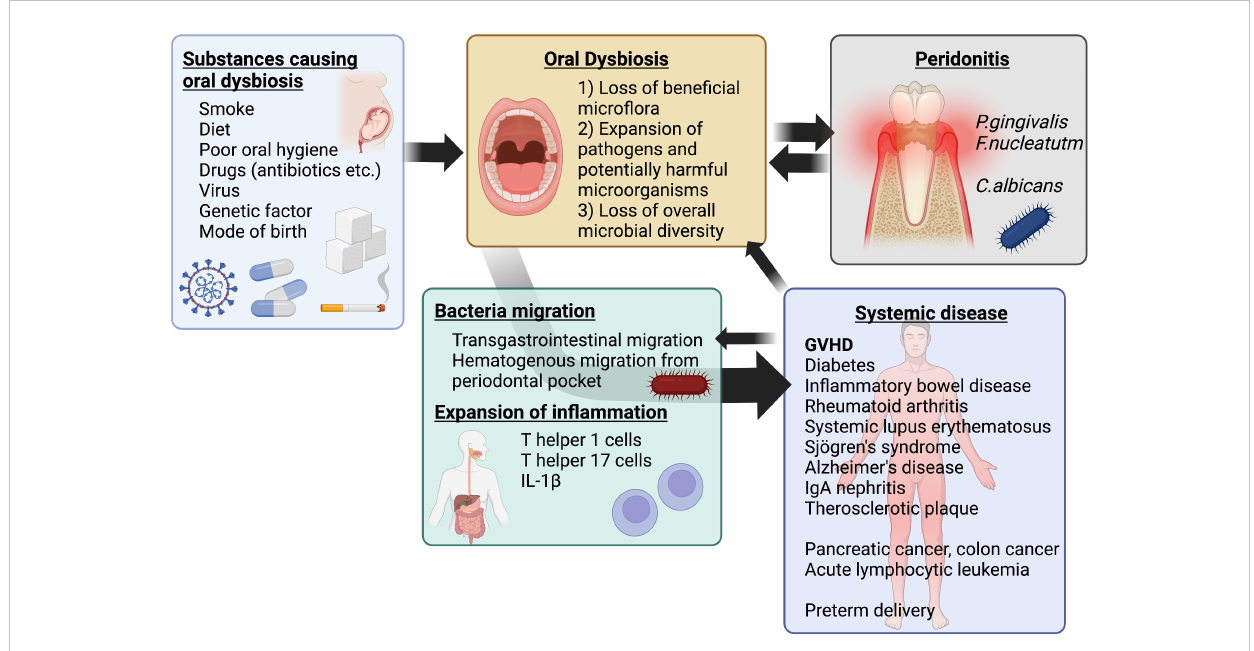
FIGURE 1 Schematic of oral dysbiosis. Oral dysbiosis is affected by environmental and genetic factors. In addition, it develops as a complementary exacerbating factor for periodontal disease and some systemic diseases, such as diabetes mellitus. The resulting systemic transfer of bacteria and spillover of in fl ammation contribute to systemic diseases, including GVHD after transplantation. Created with